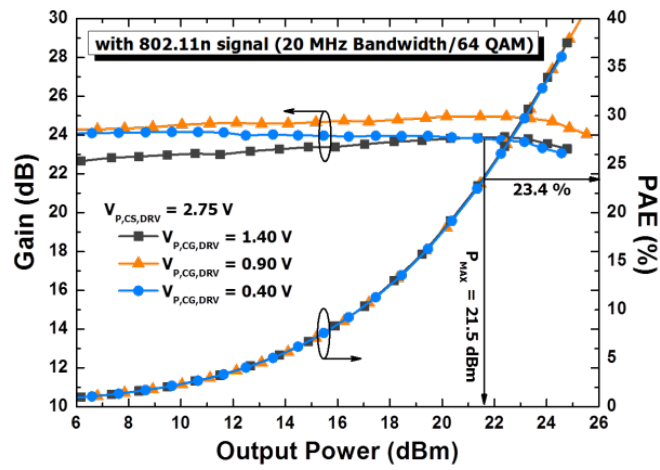
P,CS,DRV and V P,CG,DRV are 2.75 V and 0.40 V, respectively.